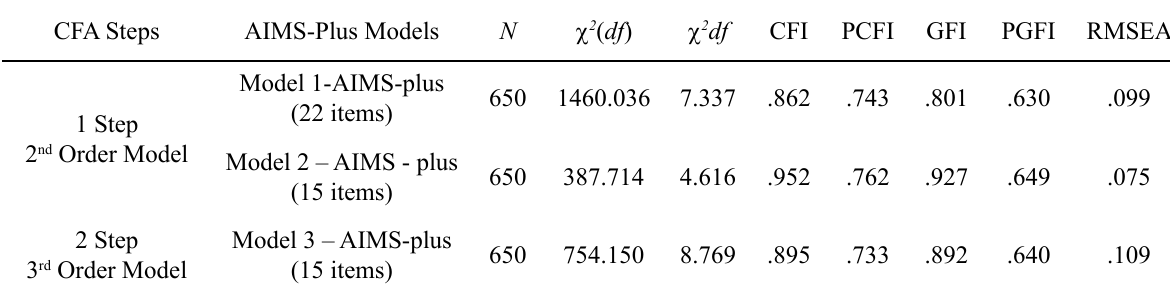
Goodness of Fit Indices for the Model of the Con fi rmatory Factor Analyses Evolution Process of the AIMS-plus